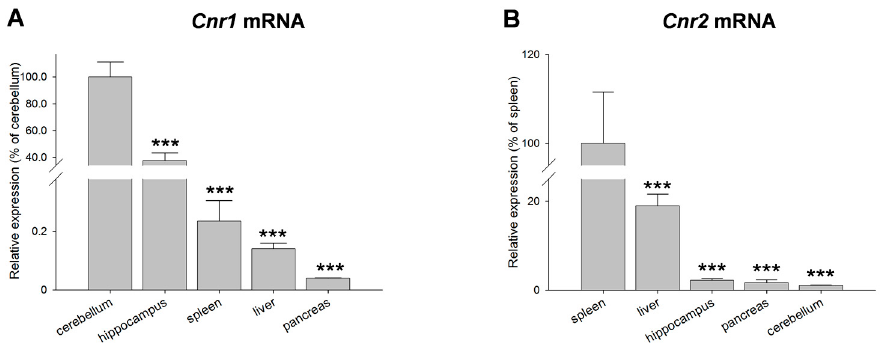
Figure 2. ( A , B ) Relative expression levels of Cnr1 and Cnr2 transcripts in cerebellum, hippocampus, spleen, liver and pancreas as means (±S.E.M.) of n = 4–6 rats, *** p < 0.001.